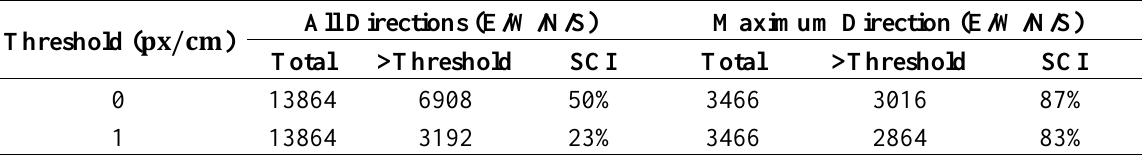
Figure 13. Surveillance resolution at the sampled locations, when the orientation is the one direction where the maximum resolution is attained. Table 2. Surveillance Coverage Index (SCI) along a certain